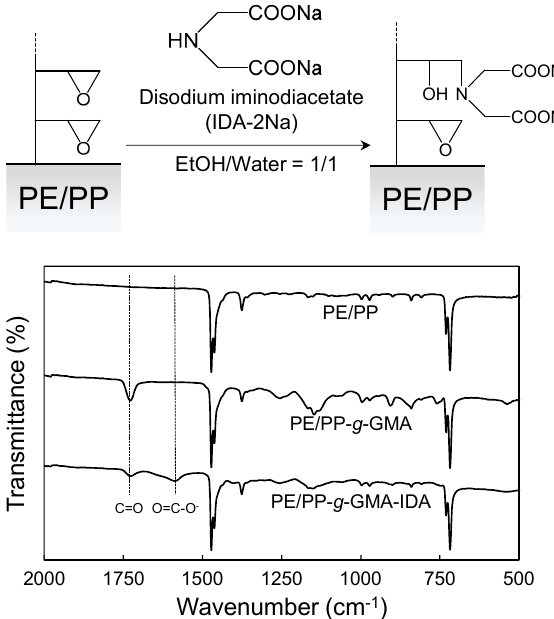
Figure 5. FTIR-ATR spectra of the PE/PP, PE/PP- g -GMA, and PE/PP- g -GMA-IDA fabrics.